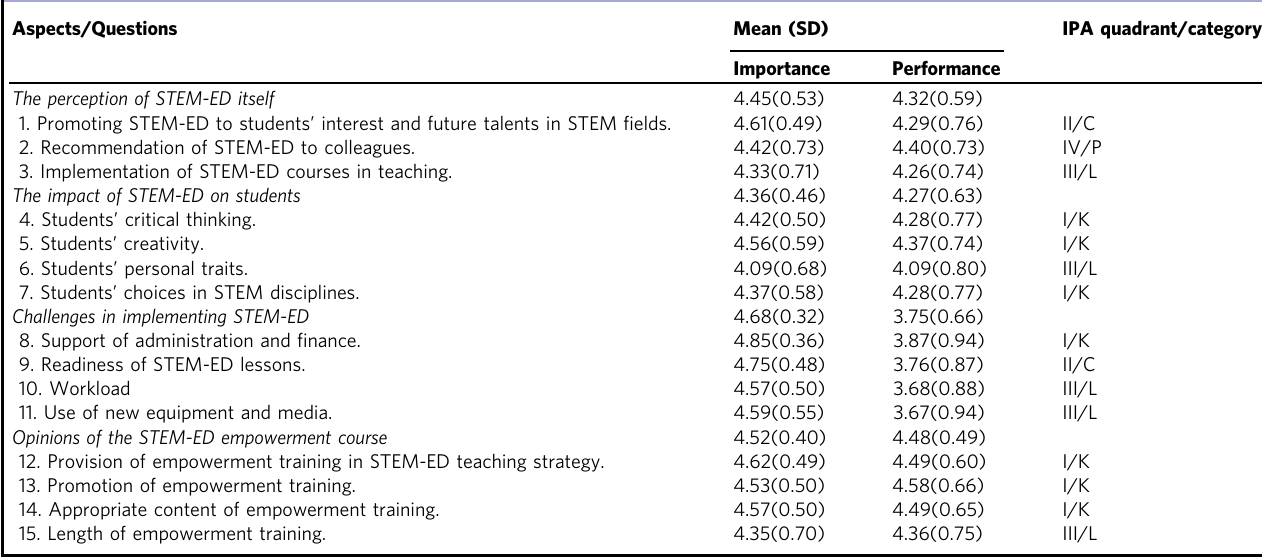
Table 3 Analysis results of the IPA questions.